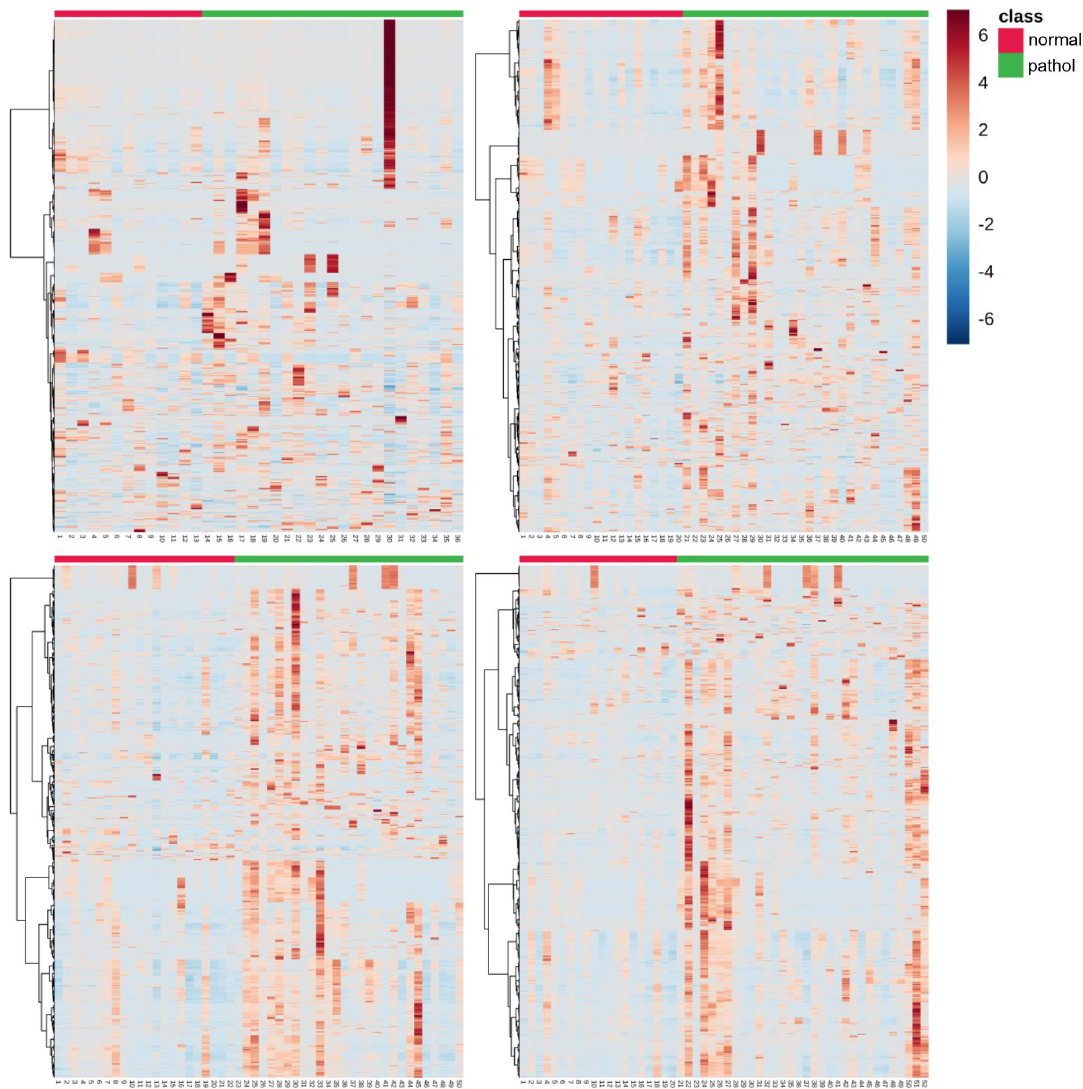
Figure 4. Heat maps of altered plasma metabolic features ( N = 2071) in samples collected at: 0 h (top, left); 24 h (top, right); 48 h (bottom, left); and 72 h (bottom, right). Note: normal vs. pathologic at 0 h N = 13 and 23; at 24 h N = 20 and 30; at 48 h N = 22 and 28; and at 72 h N = 20 and 32, respectively; blood samples were extracted at birth and at 24, 48, and 72 h after the administration of the first dose of medication /